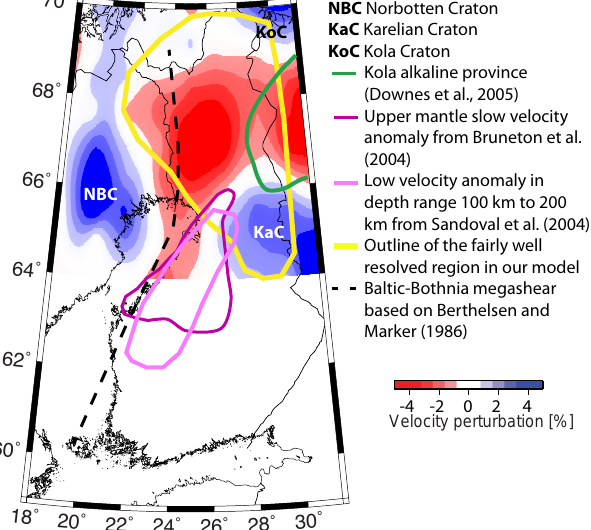
Figure 13. Our results at the depth of 120km together with cratonic units in our study area and locations of the Kola alkaline province, an upper mantle low-velocity anomaly found in SVEKALAPKO data by Bruneton et al. (2004) and Sandoval et al. (2004), and Baltic-Bothnia